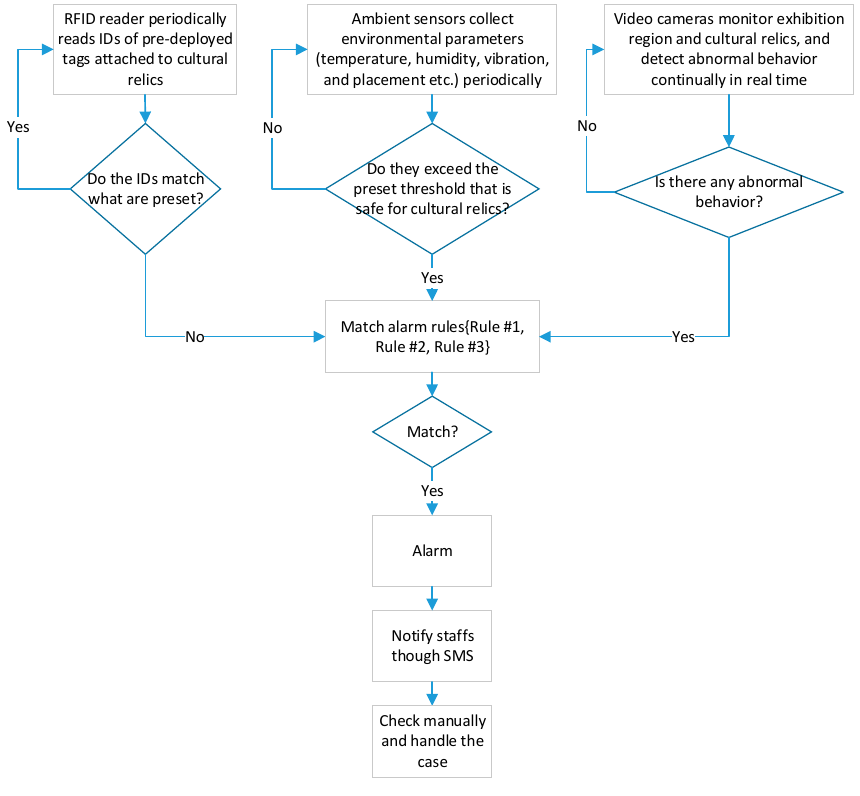
Figure 8. Flowchart of collaborative loss prevention for cultural relics.